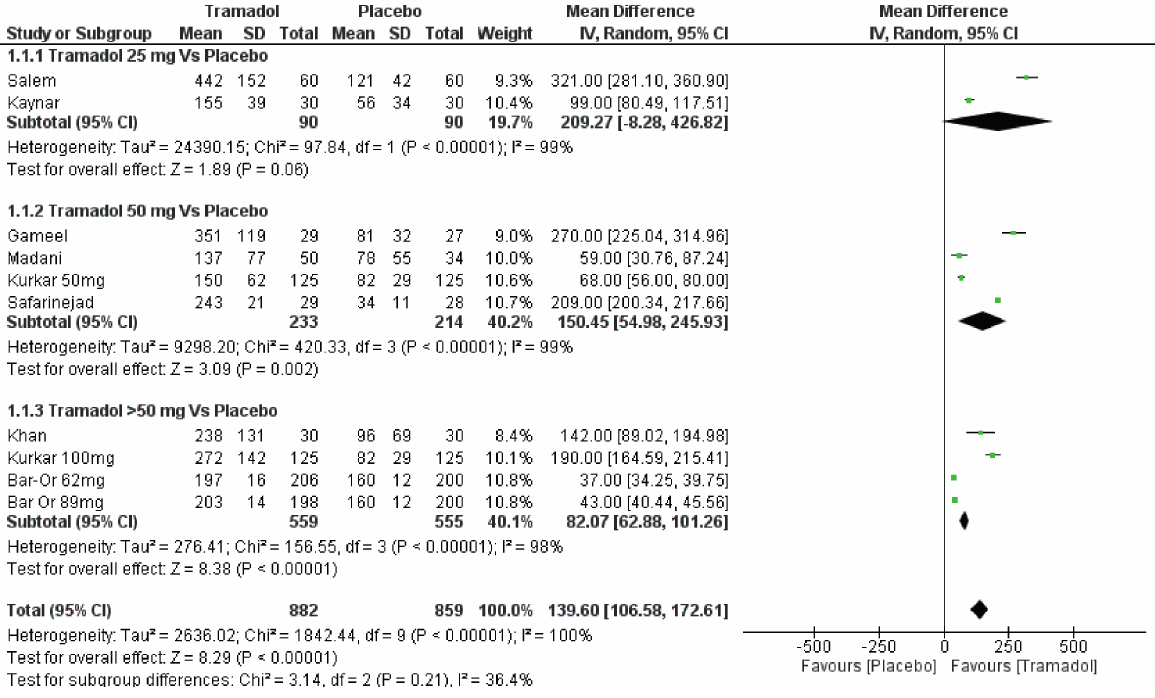
Figure-3 - Forest plot depicting comparison of various dosages of Tramadol to placebo in Premature ejaculation.